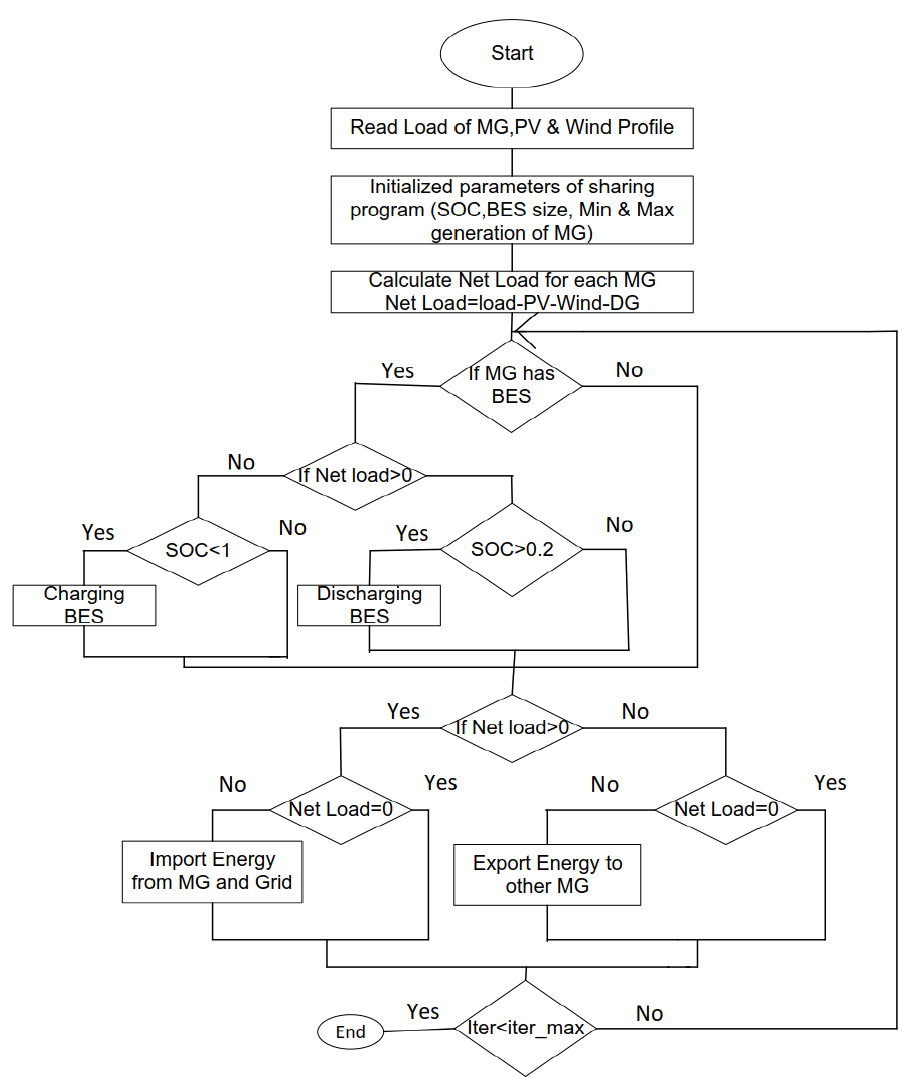
Figure 7. Flowchart of the proposed idea.